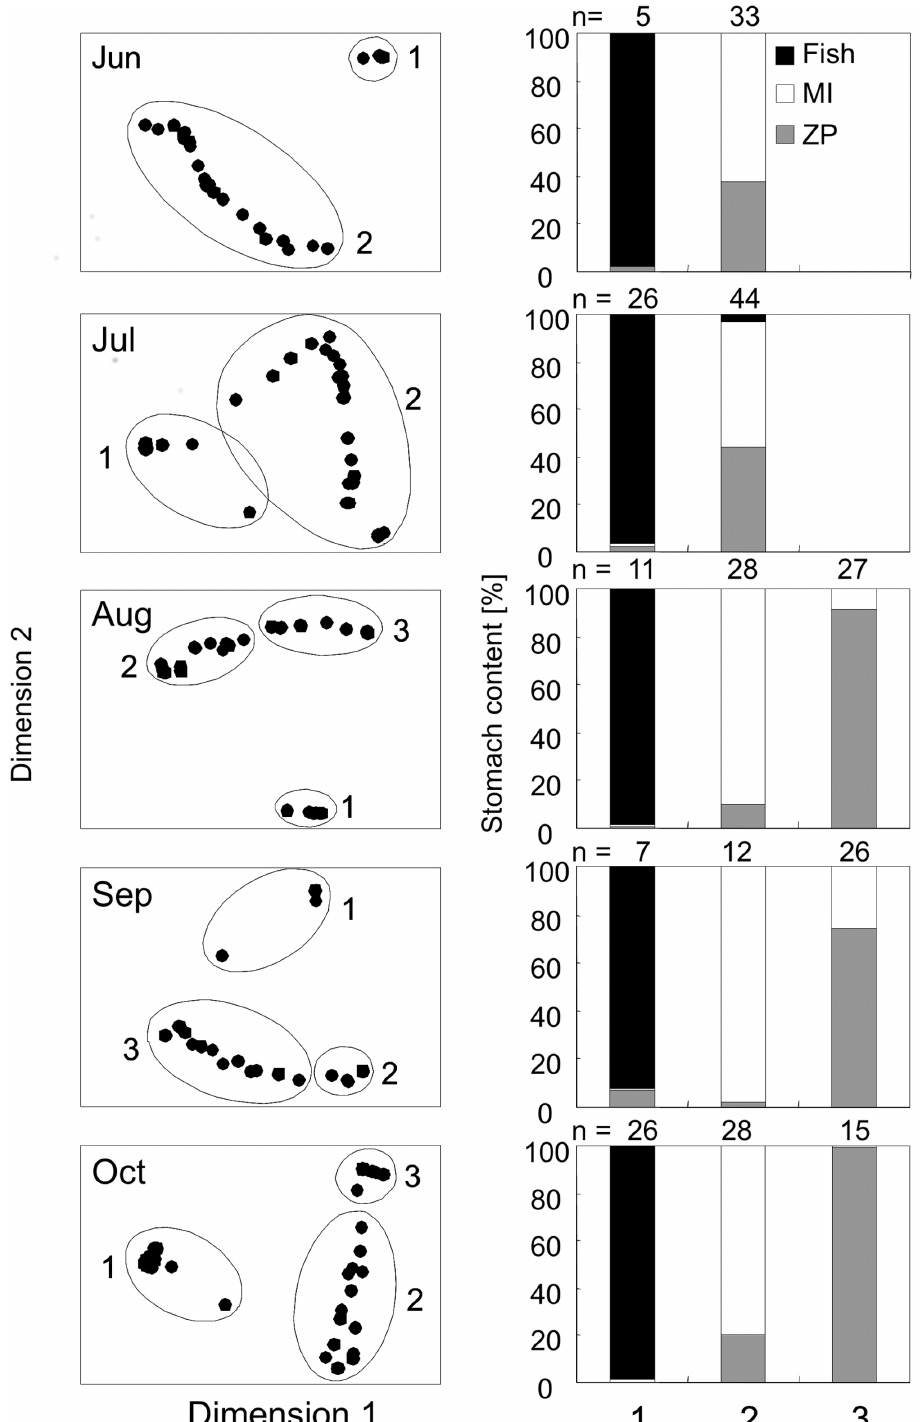
Fig 1. Cluster analysis based on diet of Eurasian perch as well as stomach content of perch. Left panel: non-metric multidimensionalscaling (MDS) plot of hierarchical cluster analysisbasedon Bray–Curtis similarity index of stomach content analysisof Eurasianperch ( Perca fluviatilis ).The MDS plot was drawn for a similarity level of 30% and a stress of 0.01. Right panel: Stomach content [% of wet biomass] of perch in clusters 1 to 3 throughout the season. MI = Macroinvertebrates, ZP = Zooplankton.